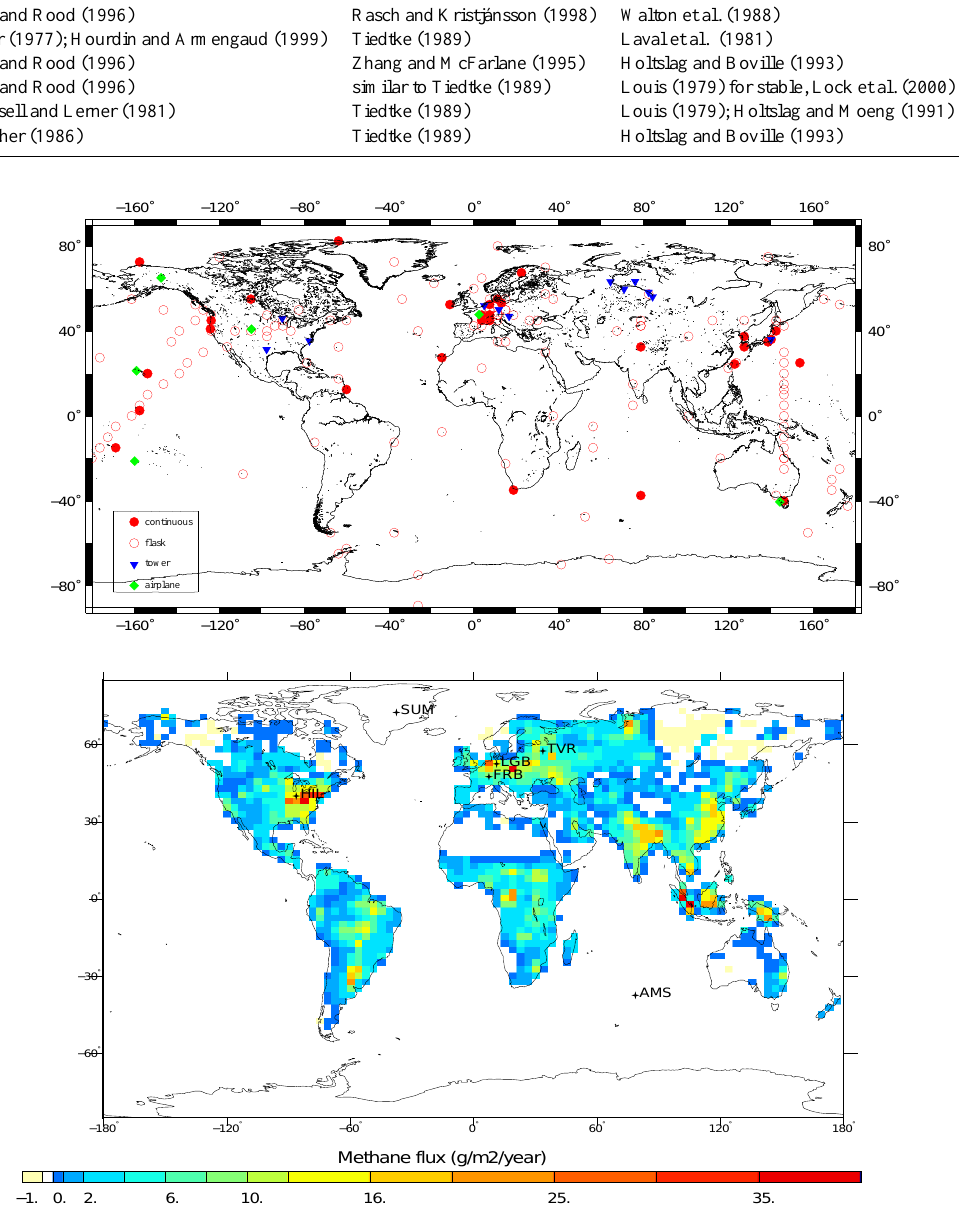
Fig. 2. Geographical representation of the two main inversion components: atmospheric constraint locations (top) and the INV emission scenario